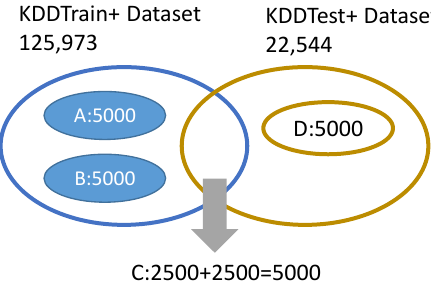
Figure 1. Data sampling diagram.